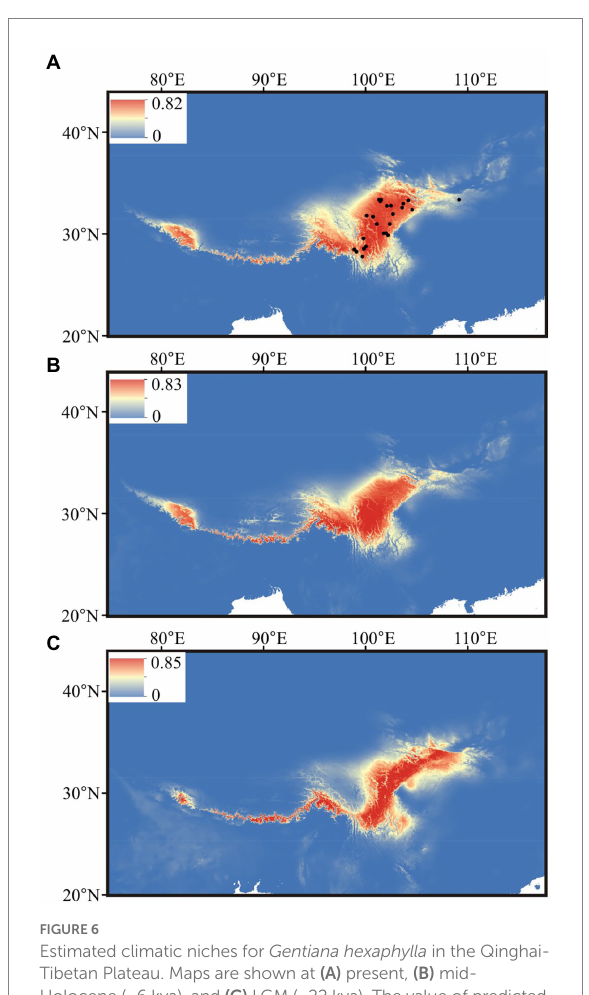
FIGURE 6 Estimated climatic niches for Gentiana hexaphylla in the Qinghai- Tibetan Plateau. Maps are shown at (A) present, (B) mid- Holocene (~6 kya), and (C) LGM (~22 kya). The value of predicted habitat suitability is indicated by the bars in each panel. Current distribution records are shown in the present map by black